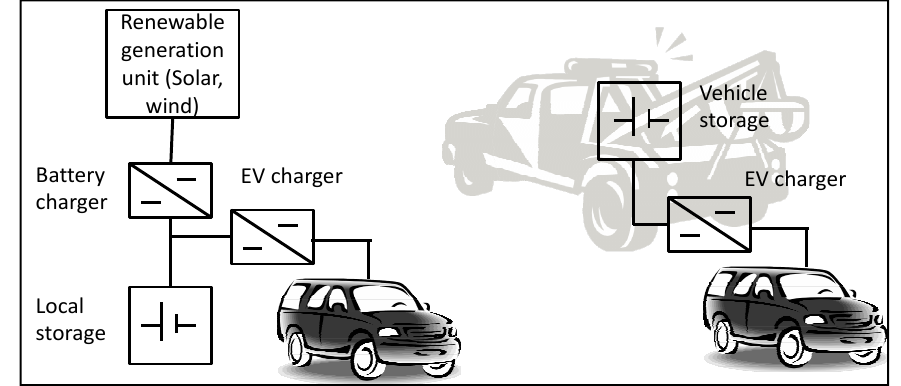
Figure 5. Off-grid charging station and fast charging service vehicle